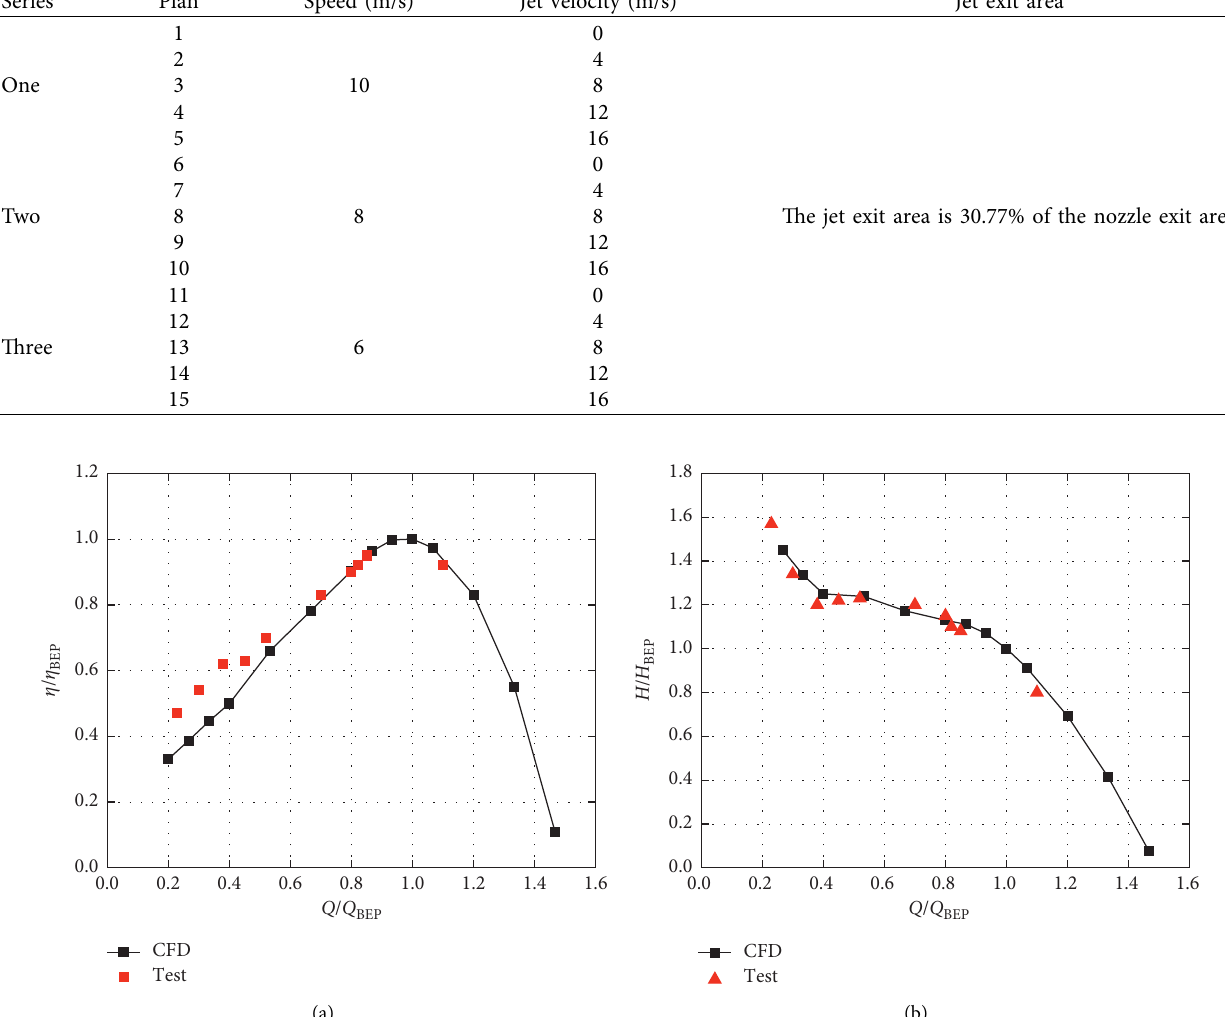
Figure 5: Comparison of numerical simulation and experimental results. (a) Q- η curve. (b) Q-H